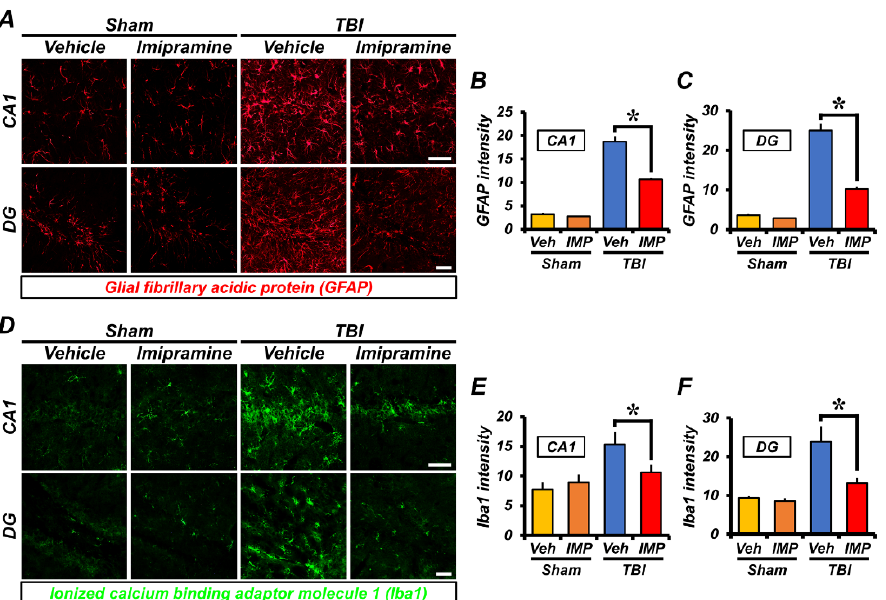
Figure 4. Imipramine treatment reduced glial activation 24 h after TBI. ( A ) Representative images showing astrocytes and microglia stained with GFAP (red) in the hippocampal CA1 and DG. Scale bar = 100 µ m. ( B , C ) Quantification of astrocyte activation in hippocampal CA1 and DG. Data are mean ± SEM; n = 4 from each sham group; n = 6 from each TBI group. * p < 0.05 vs. vehicle-treated TBI group. ( D ) Immunofluorescence images showing Iba-1 (green) in hippocampal CA1 and DG. Scale bar = 100 µ m. ( E , F ) Bar graph represents activation intensity of microglia in hippocampal CA1 and DG. Data are mean ± SEM; n = 4 from each sham group; n = 6 from each TBI group. * p < 0.05 vs. vehicle-treated TBI group.